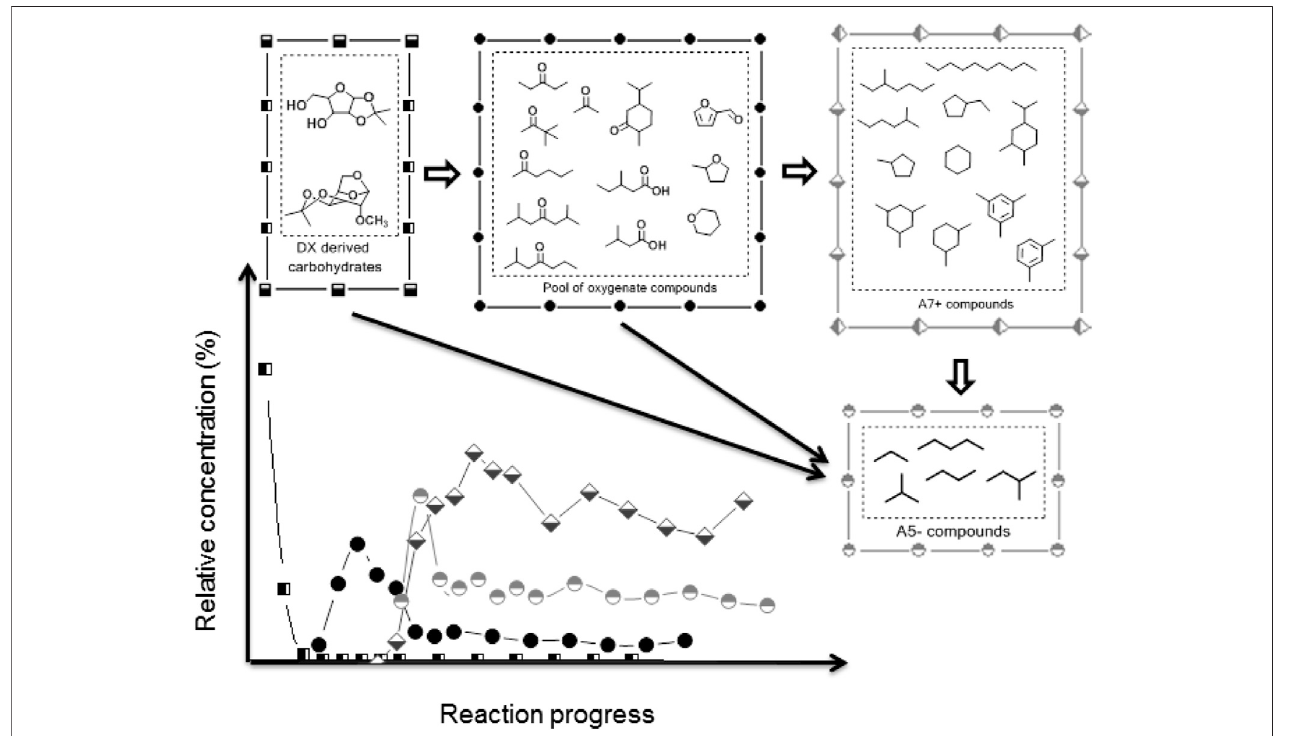
FIGURE 7 | Insight into DX HDO pathways and main compounds involved in these